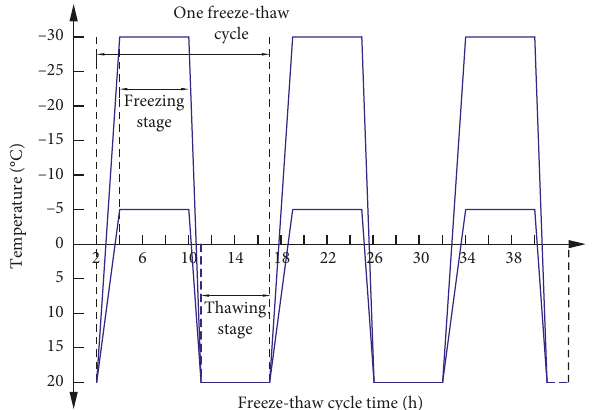
Figure 5: Temperature profile of the yellow sandstone samples undergoing the F-T